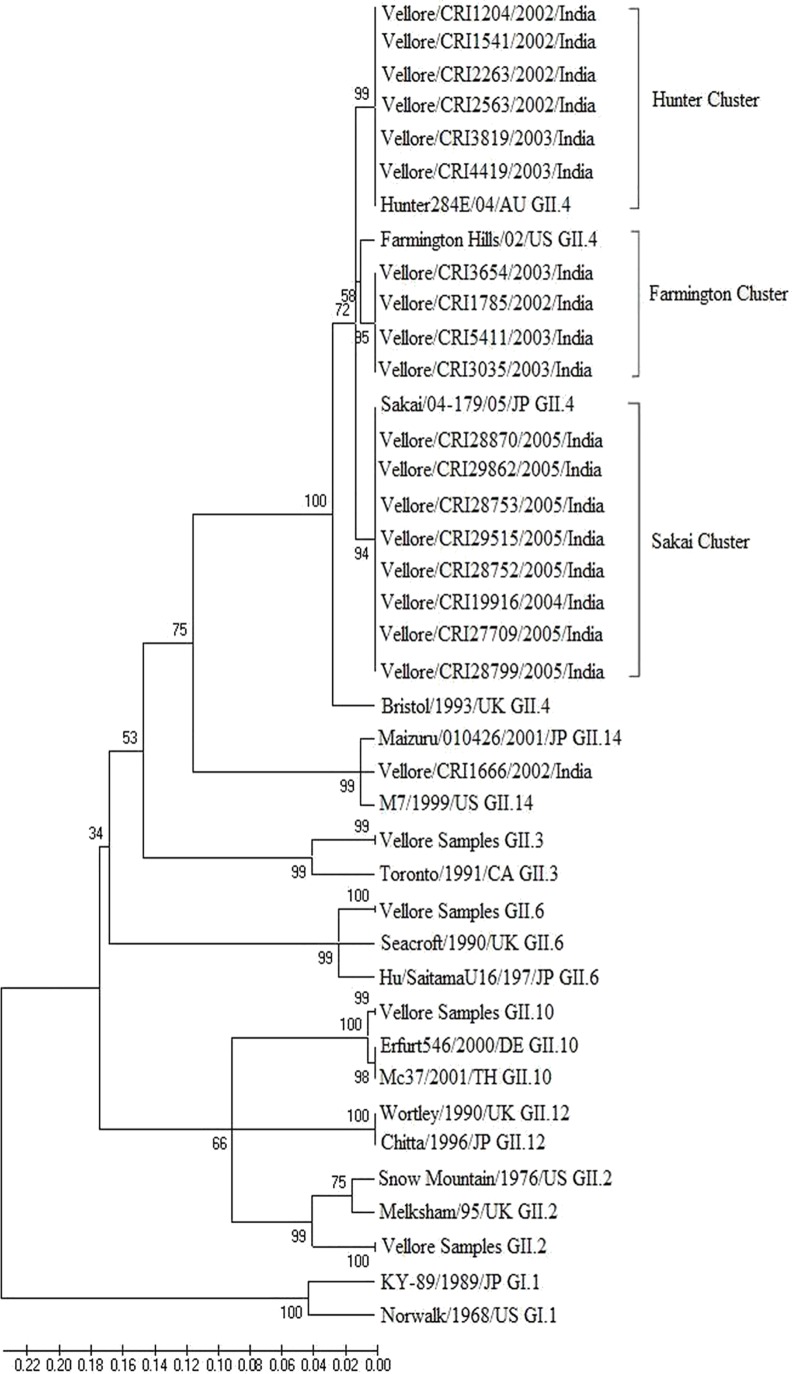
Dendrogram constructed using neighbor joining of nucleotide sequences corresponding to fragment of 468 bp of the ORF 1–2 region of the Norovirus capsid encoding gene.Bootstrap values for 10000 pseudo replicates are shown. The reference strains included for comparison with accession numbers are: Hunter284/04/AU (DQ078794), Farmington Hills/02/US (AY502023), Sakai/04-179/05/JP (AB220922), Bristol/1993/UK (X76716), Maizuru/010426/2001/JP (EF547404), M7/1999/US (AY130761), Toronto/1991/CA (AAA18930), Seacroft/1990/UK (AJ277620), Hu/SaitamaU16/197/JP (AB039778), Erfurt546/2000/DE (AF427118), Mc37/2001/TH (AY237415), Wortley/1990/UK (AJ277618), Chitta/1996/JP (AB032758), Snow Mountain/1976/US (AY134748), Melksham/95/UK (X81879), KY-89/1989/JP (L23828), Norwalk/1968/US (M87661).